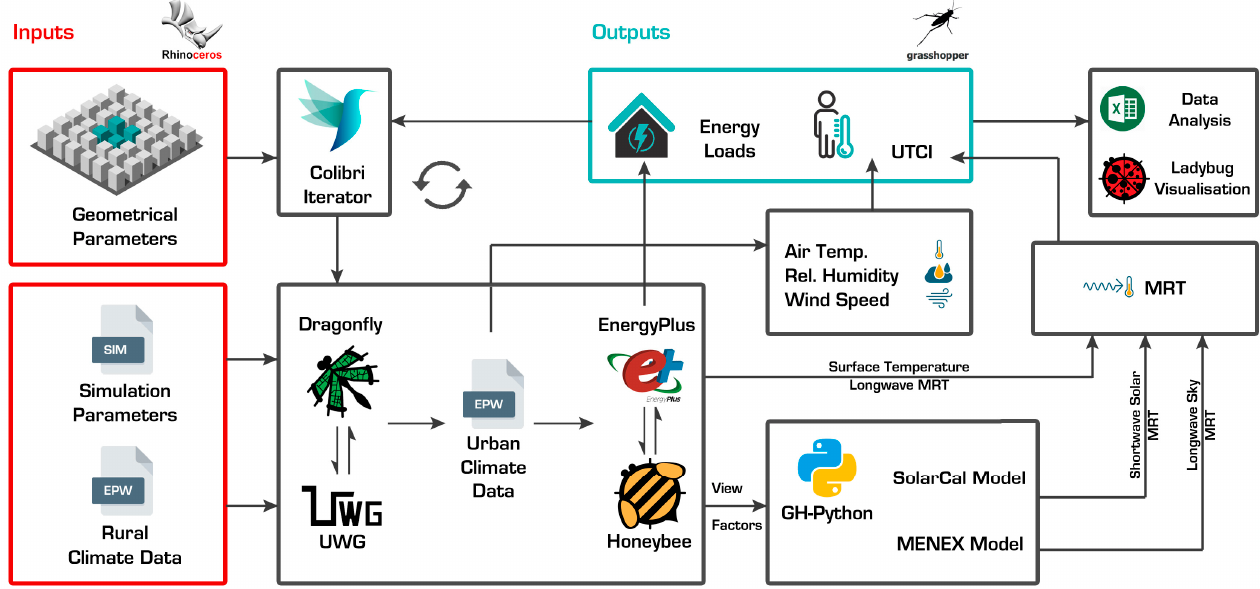
Figure 2. Simulation workflow showing the streaming of data between different Grasshopper components.